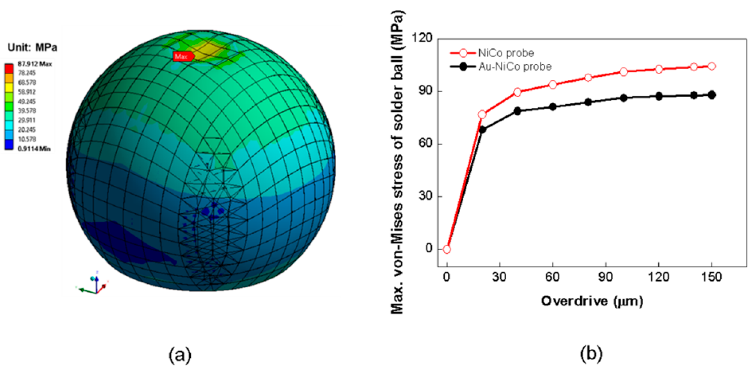
Figure 7. ( a ) The von Mises stress distribution map of the solder ball when the probe was in contact with the solder ball. ( b ) The variation in maximum stress in the solder ball with increasing overdrive.